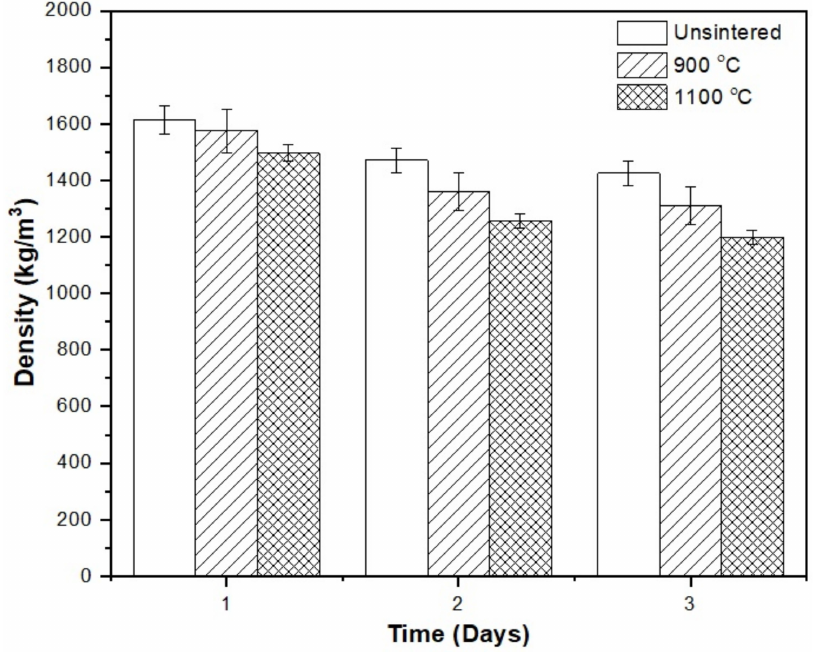
Figure 2. The density of kaolin geopolymer over 3 days for unsintered and sintered samples at 900 and 1100 ◦